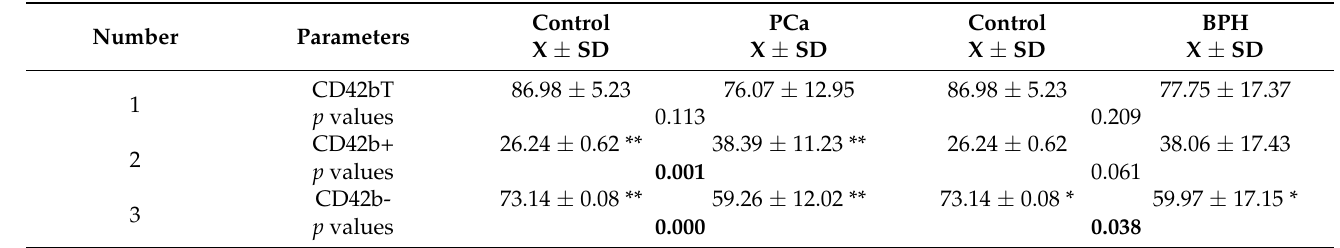
Table 3. CD42b glycoprotein expression at prostate adenocarcinoma, benign prostatic hyperplasia, and non-malignant adjacent tissue samples.